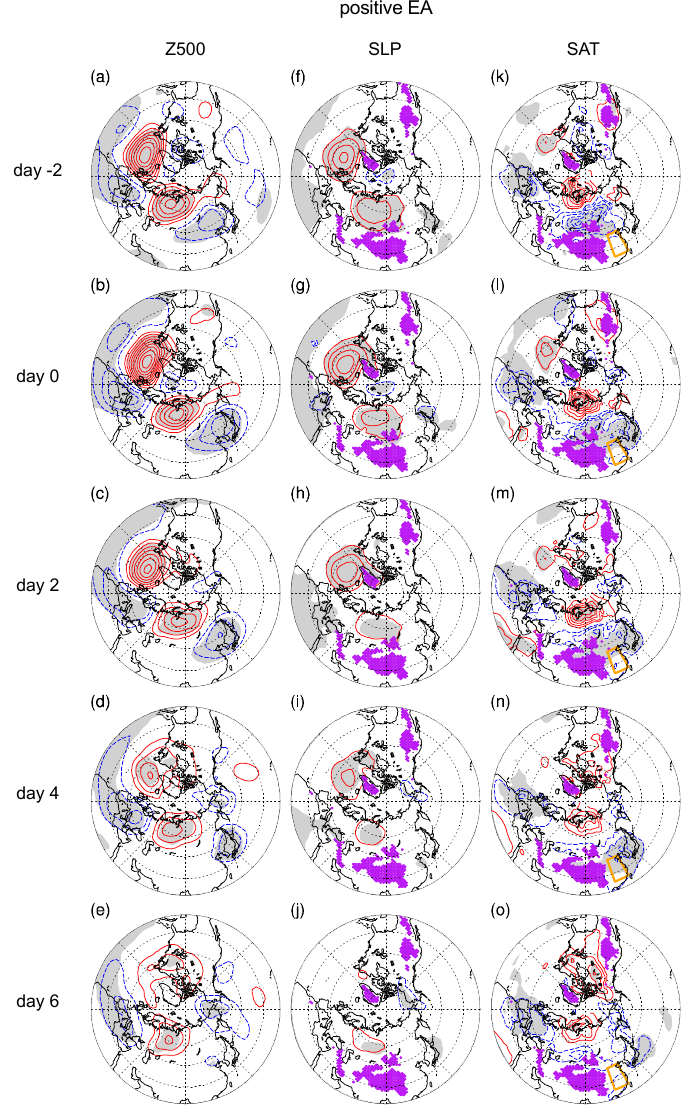
Figure 5. (a – o) Same as subfigures (a – o) of Figure 4, respectively, but for 51 positive EA events. Figure 5. ( a – o ) Same as subfigures ( a – o ) of Figure 4, respectively, but for 51 positive EA events. p are 0.006, 0.005, and 0.004 for composites of Threshold values for the significance level * Threshold values for the significance level p ∗ are 0.006, 0.005, and 0.004 for composites of anomalous FDR FDR Z500, SLP, and SAT, anomalous Z500, SLP, and SAT, respectively.